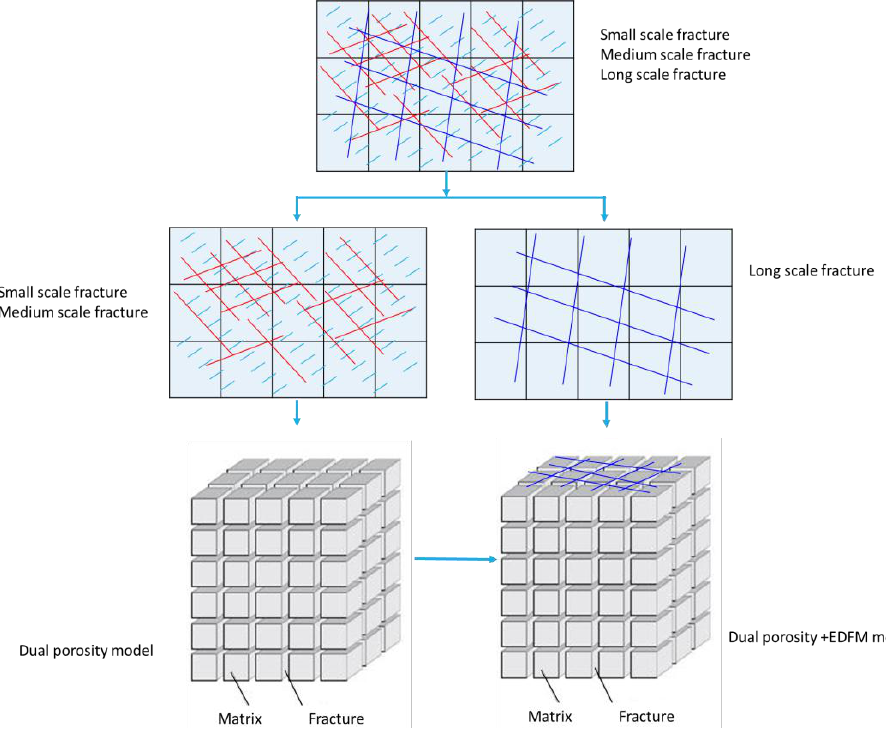
Figure 2. The process to build dual porosity dual permeability (DPDP) model and embedded discrete fracture +DPDP model (EDFM+DPDP).